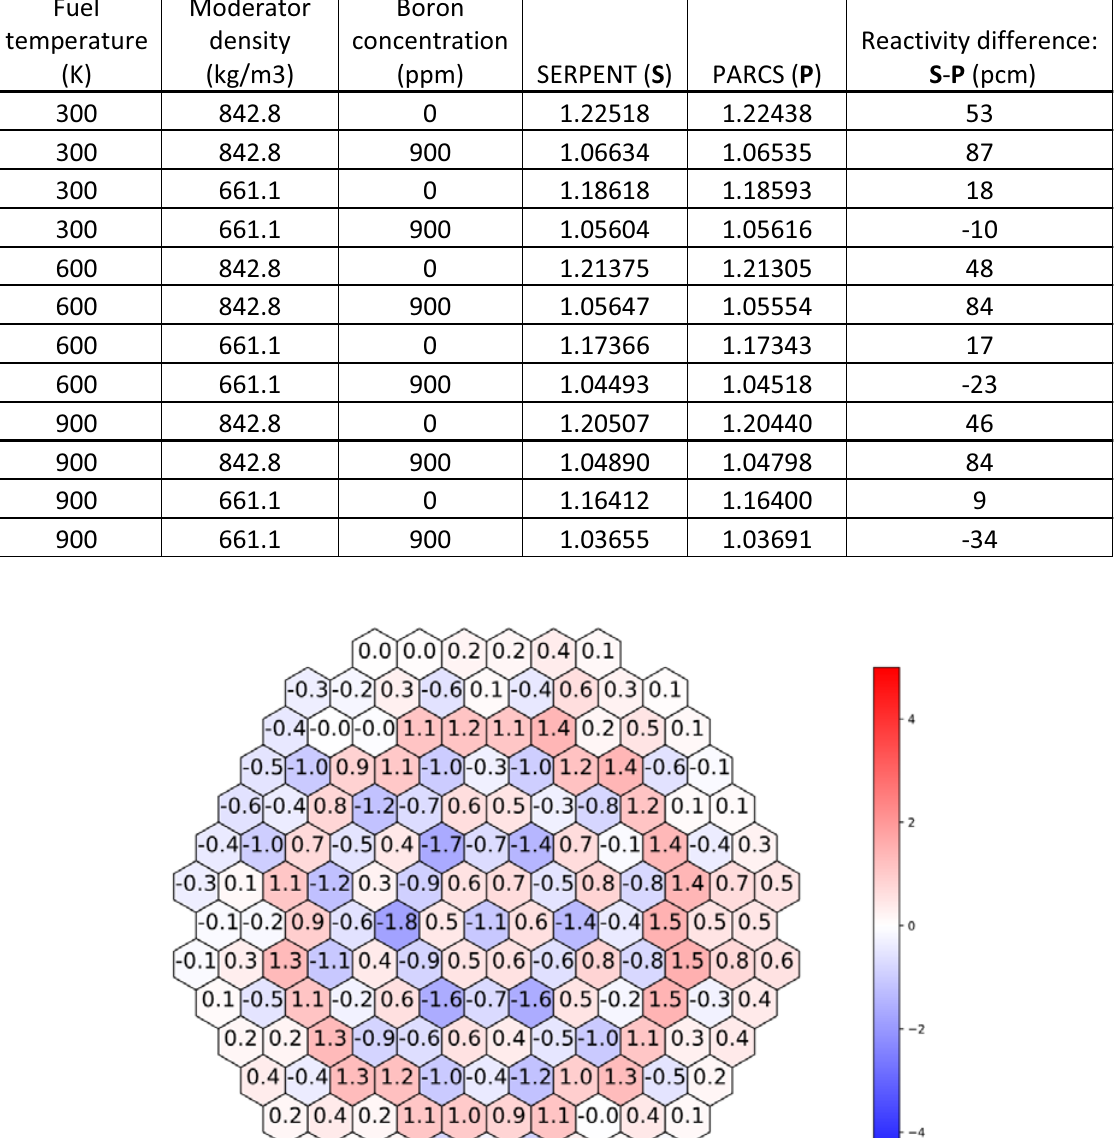
Table I : Effective multiplication factor for different core configuration